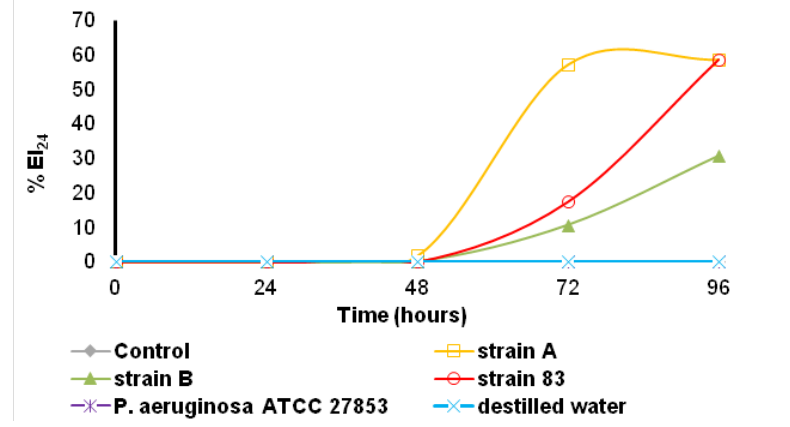
Figure 3: Surface tension of bacterial strains in MSM + WCO 2%